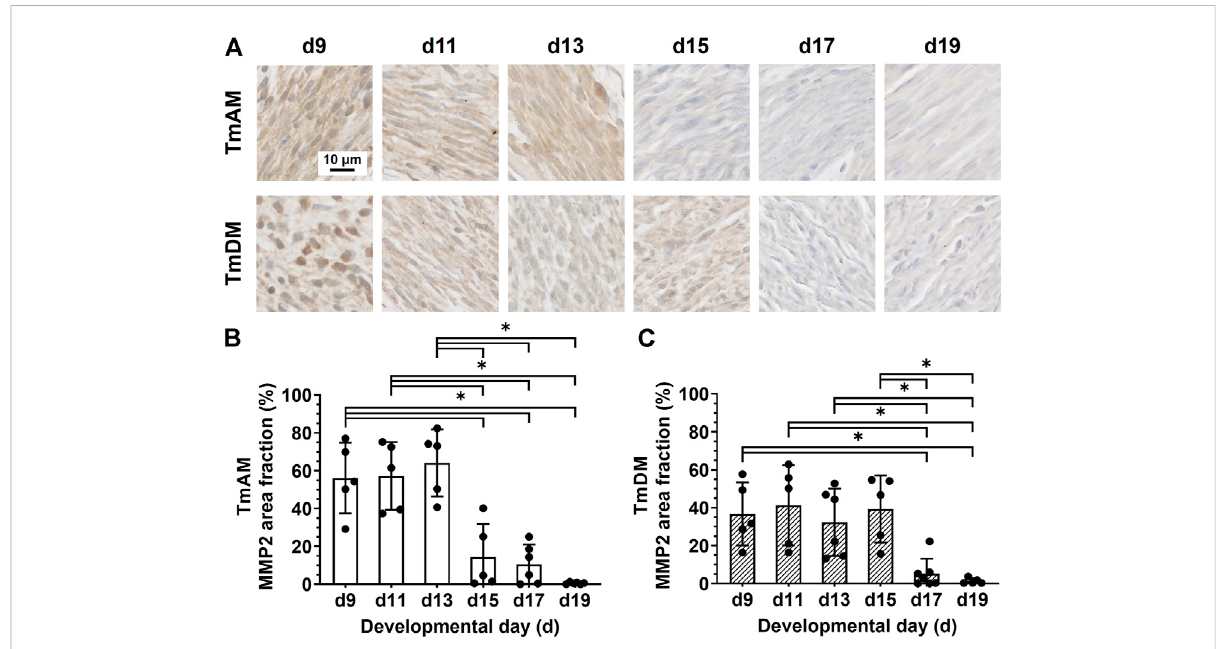
FIGURE 9 MMP2decreasedduringmid-to-laterstagesinjaw-closing TmAMandjaw-opening TmDM. (A) Representativebright fi eldimagesofMMP2 IHC of TmAM and TmDM. (B) In TmAM, percentage area fraction positive for MMP2 decreased signi fi cantly after d13. (C) In TmDM, percentage area fraction positive for MMP2 decreased signi fi cantly after